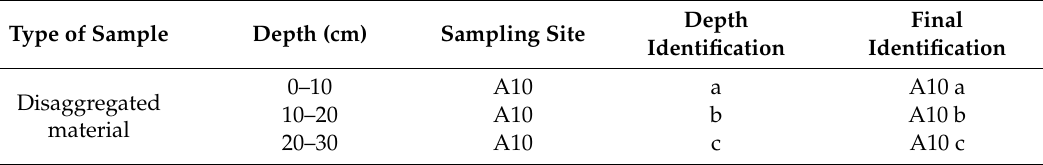
Table 1. Example of sample